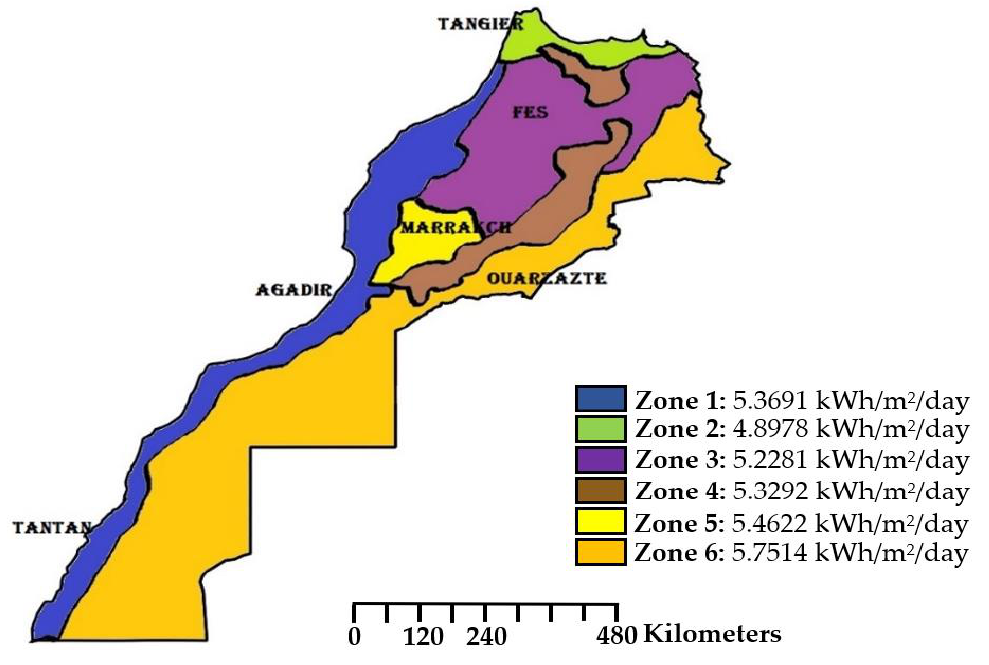
Figure 1. A map showing the climatic zones and solar intensities of the study sites. The map was sourced from: www.marocmeteo.ma (accessed on 16 March 2022) [81]. Table 2. A table showing study area: Latitude, longitude, altitude, climate region or climate type, mean annual values of relative humidity, water vapour, the total number of clear-sky days used per site where the percentage of the annual average share of clear-sky days is given in brackets.